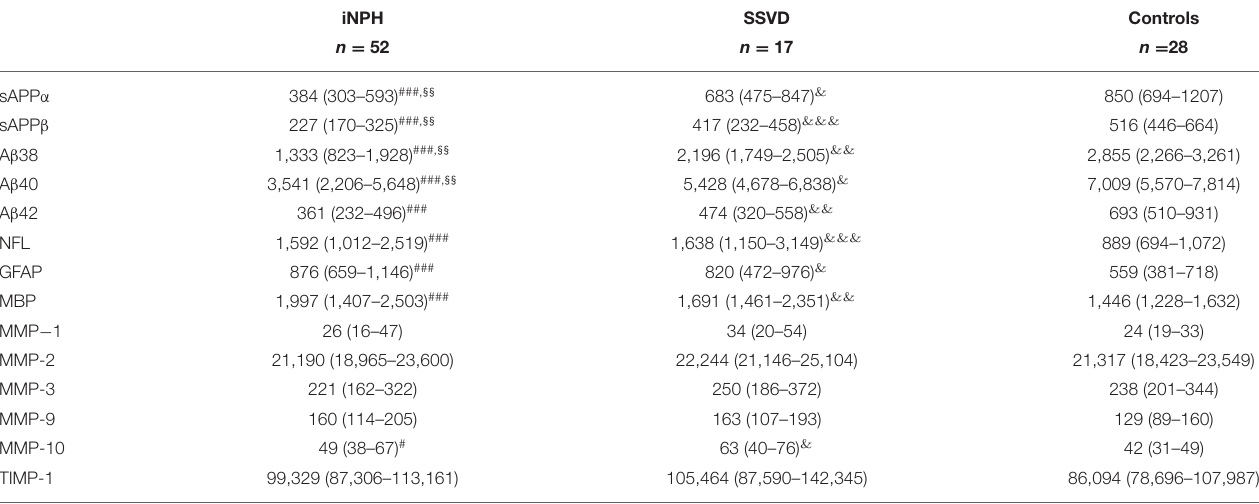
TABLE 2 | Cerebrospinal fluid (CSF) biomarker concentrations in iNPH, SSVD, and healthy controls. iNPH SSVD Controls n = 52 n = 17 n = 28